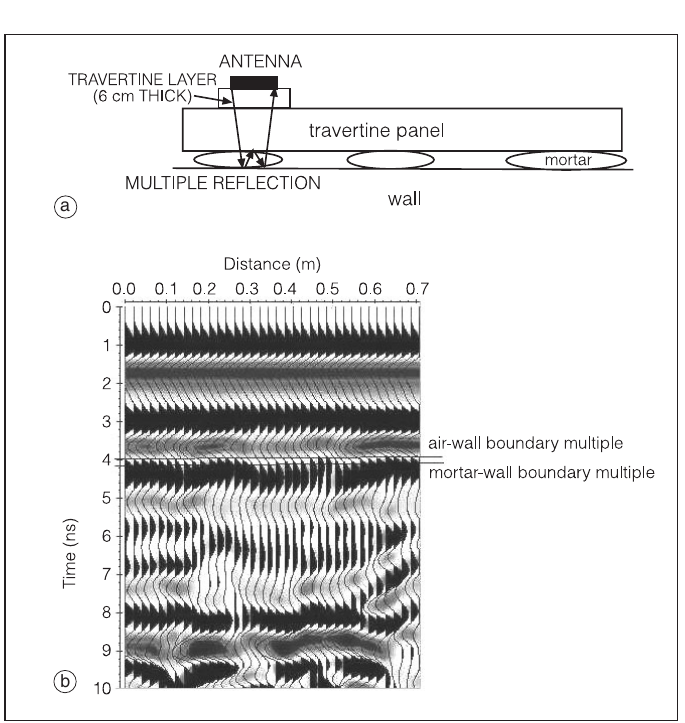
Fig. 7a,b. a) Model of radar transmission and reflection with multiple reflections off of subsurface interfaces prior to the wave’s being recorded at the surface antenna; b) radar section related to the profile B2 shown in fig. 6. The underlined multiple reflections are clearly related to the bottom of the interface air-wall and